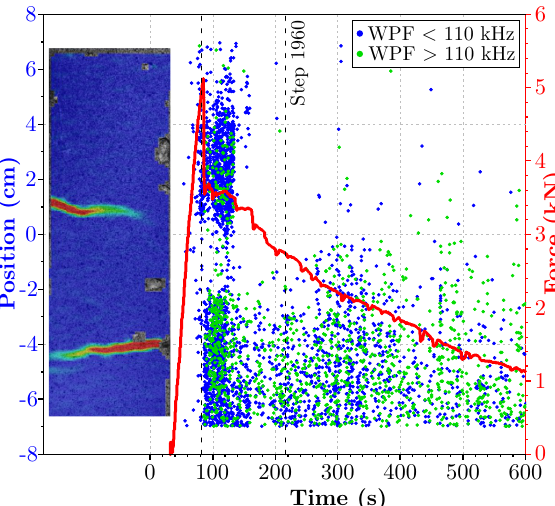
Figure 2. Averaged stress-strain curves.